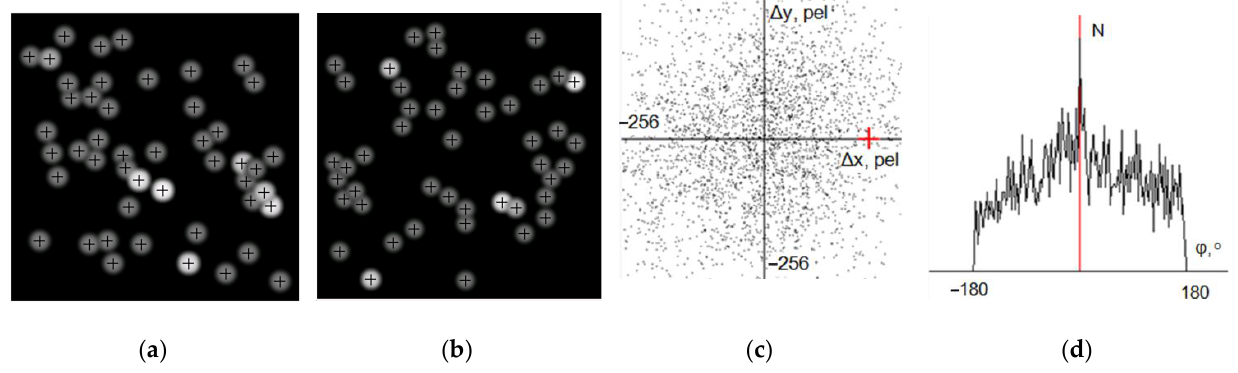
Figure 7. Results obtained by the IMBKPP method for the test images: ( a , b ) source images with marked particle centres; ( c ) the map of displacement values; ( d ) the histogram of rotation angles.